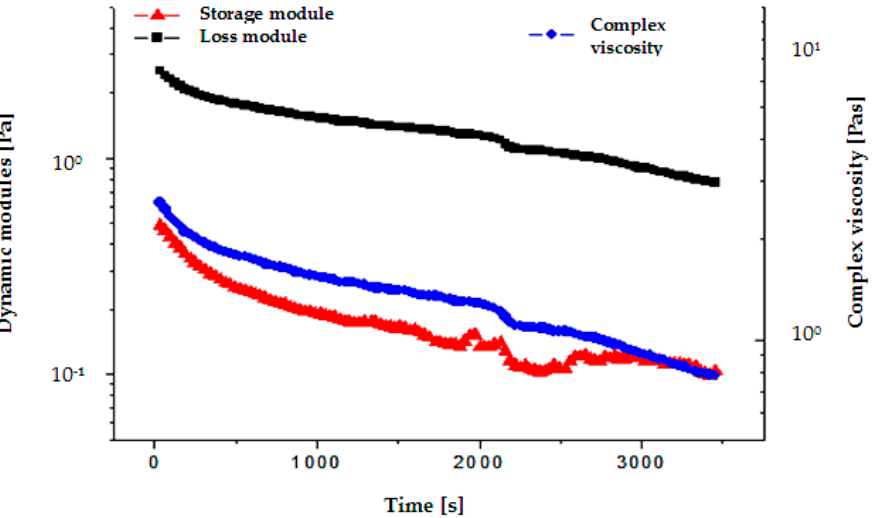
Figure 6. Loss module and complex viscosity for EM_1c after light shaking. The rheological analysis of the sample EM1b after rigorous stirring, see Figures 7 and 8, demonstrated that the storage module increased from the previous sample (Figure 6) and was approximately constant (equal to 0.012 Pa), and the complex viscosity decreased and was approximately ten times larger than that of water. This demonstrates that an appropriate emulsification occurred when the emulsifying process was accompanied by rigorous stirring.